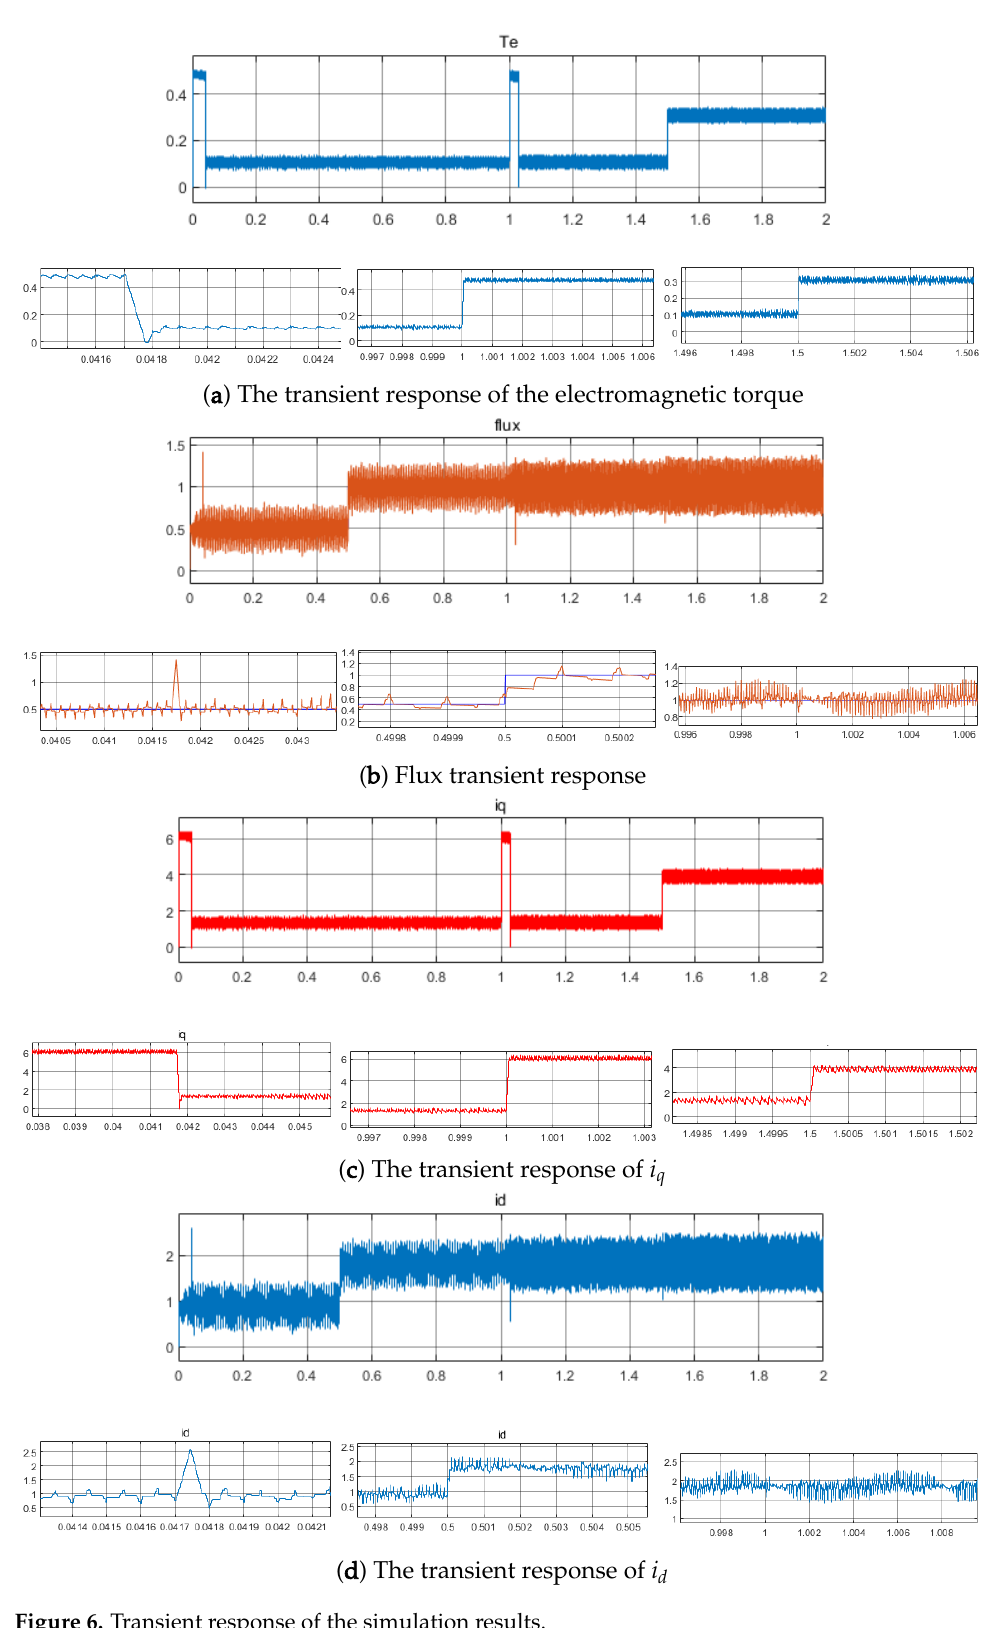
Figure 6. Transient response of the simulation results .